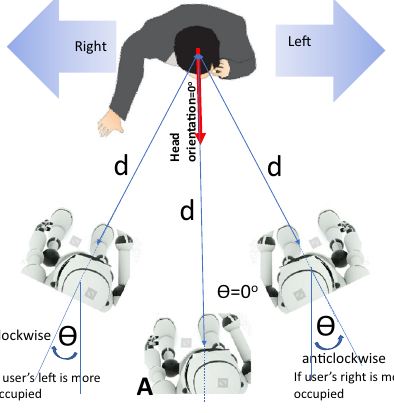
Figure 6: The top view of the HRI scenario is shown. The orientation of the robot is marked as θ . θ is measured clockwise ( if reaching user from his/her right ) or anticlockwise ( if reaching user from his/ her left ) from the